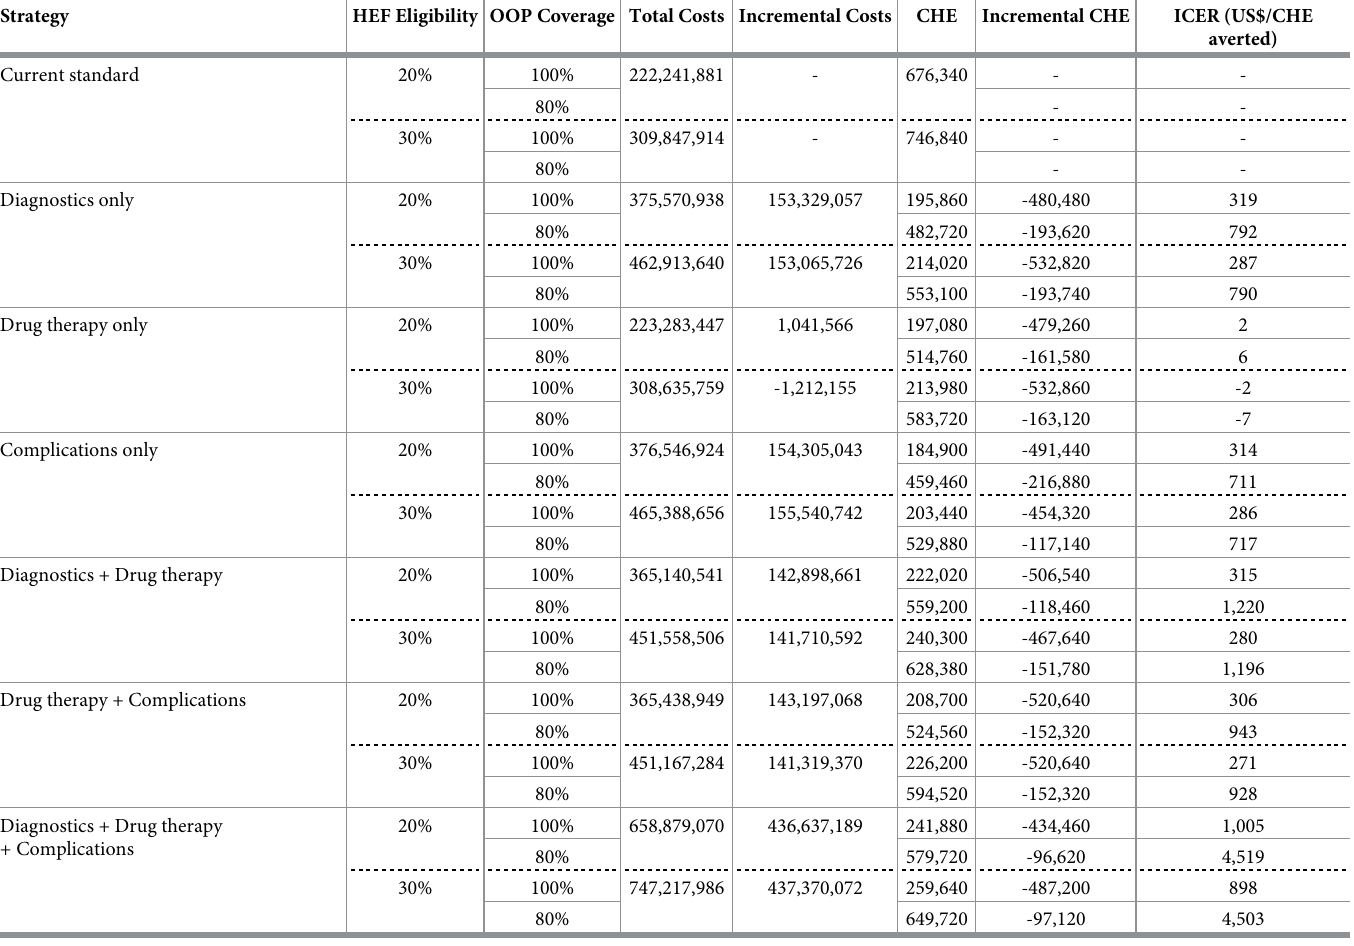
Table 4. Incremental costs and financial risk protection impact by strategy and HEF coverage scenario.